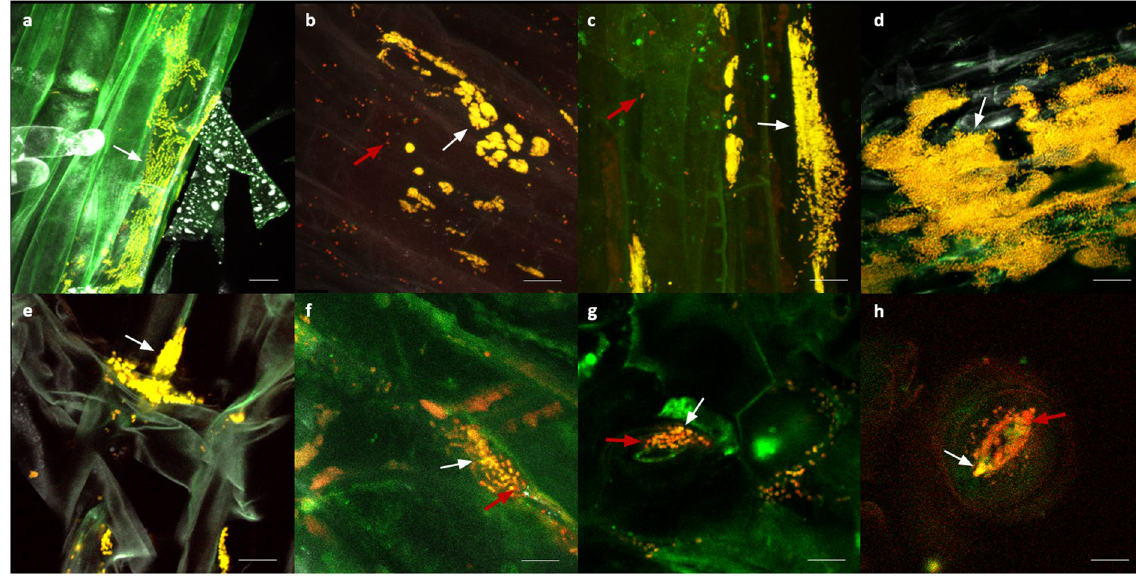
Figure 4. FISH/CLSM visualization of antagonistic bacterial strains colonizing oilseed rape seedlings. Expected colonies, denoted by white arrows, appear yellow due to overlay of the fluorochromes Cy3 and Cy5. Red arrows indicate other bacterial organisms which are presumably seed-borne. ( a ) Rhizosphere with P. fluorescens F2; ( b ) Rhizosphere with S. plymuthica F20; ( c ) rhizosphere with P. protegens F37; ( d ) rhizosphere with P. fragi W31;